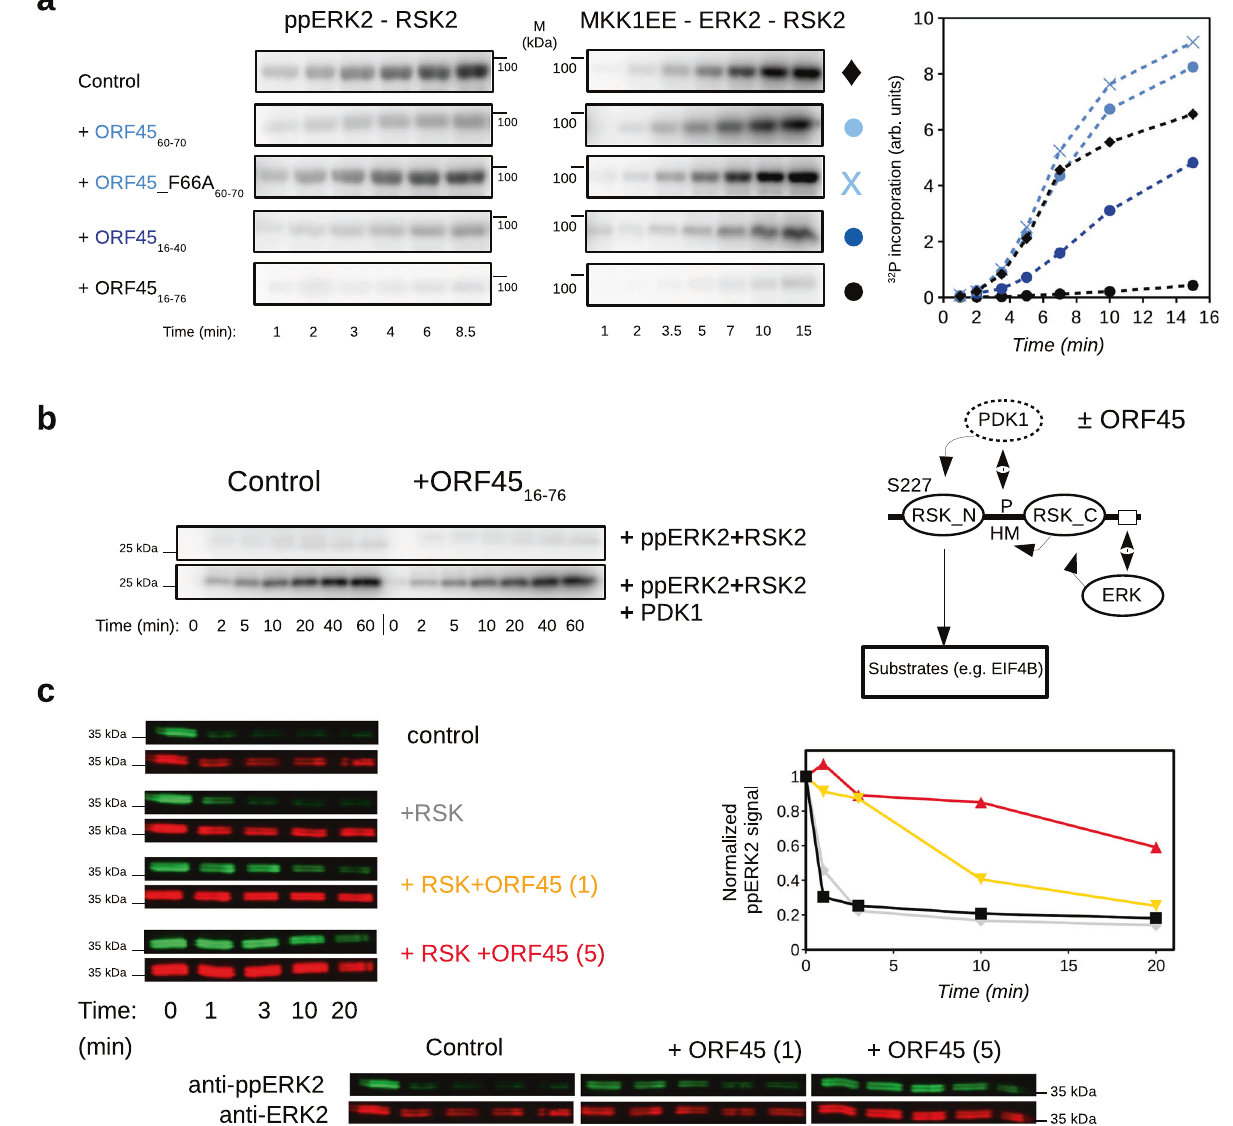
Fig. 5 RSK substrate phosphorylation and ERK/RSK dephosphorylation ± ORF45. a In vitro kinase assay results of RSK2 phosphorylation. Left panel: 10 nM ppERK2 was used to phosphorylate RSK2 (2 µ M) and RSK2 phosphorylation was monitored at different time points by phosphorimaging in the absence (Control) and the presence of ORF45 peptides (50 µ M). Middle panel: 0.25 µ M activated MKK1 (MKK1EE) was mixed with 2 µ M nonphosphorylated ERK2 and 2 µ M RSK2; and RSK2 phosphorylation was monitored similarly as on the left panel. Phosphorimaging results are plotted on the panel at the right based on one experiment ( N = 1). b In vitro kinase assay results on RSK substrate phosphorylation. 0.5 µ M ppERK2 and 1 µ M RSK2 was pre-incubated for 1 h, then 10 µ M PDK1 was added and the phosphorylation of 10 µ M GST-4EIFBpep — an RSK model substrate — was monitored in the absence (Control) or the presence of 10 µ M ORF45(16-76) ( N = 1). The schematic panel on the right highlights the hierarchical phosphorylation events (one-end arrows) and the PPIs (two-end arrows) required for NTK mediated phosphorylation of RSK substrates. (HM hydrophobic motif). c Results of ppERK2 dephosphorylation assays in the presence of RSK2 and ORF45. Control: 1 μ M ppERK2 was incubated with 1 μ M puri fi ed MKP3 and dephosphorylation was monitored by quantitative Western-blots (green signal: anti-phosphoERK2; red signal: anti-ERK2). Lower panels show the results of the same dephosphorylation assay but in the presence of 1 μ M RSK2 and 1 or 5 μ M ORF45(16-76). Panels at the bottom show results of the same assay but containing ORF45(16-76) without RSK ( N = 1). Source data are provided as Source data fi